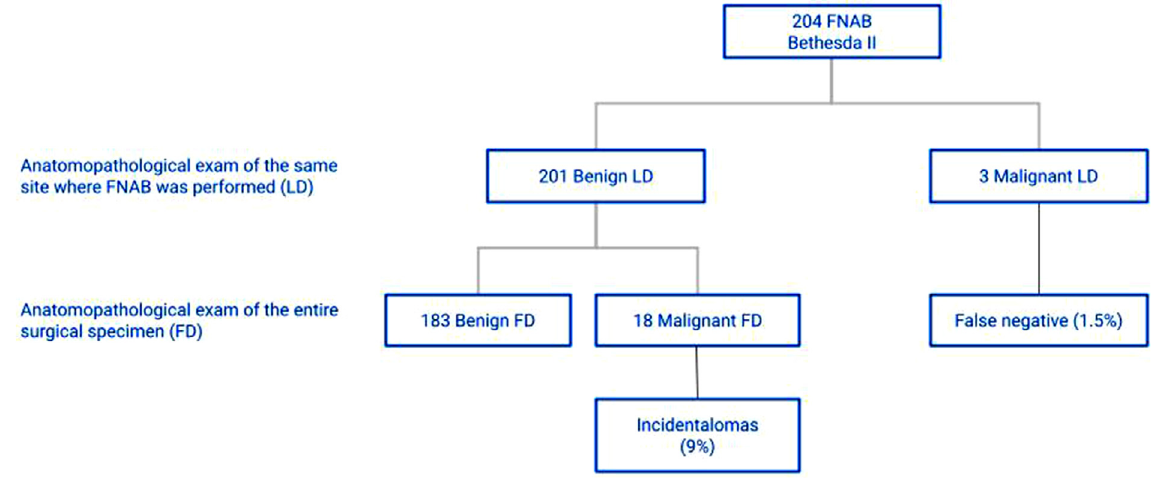
Fig. 1. Anatomopathological exams of patients categorized as Bethesda II.